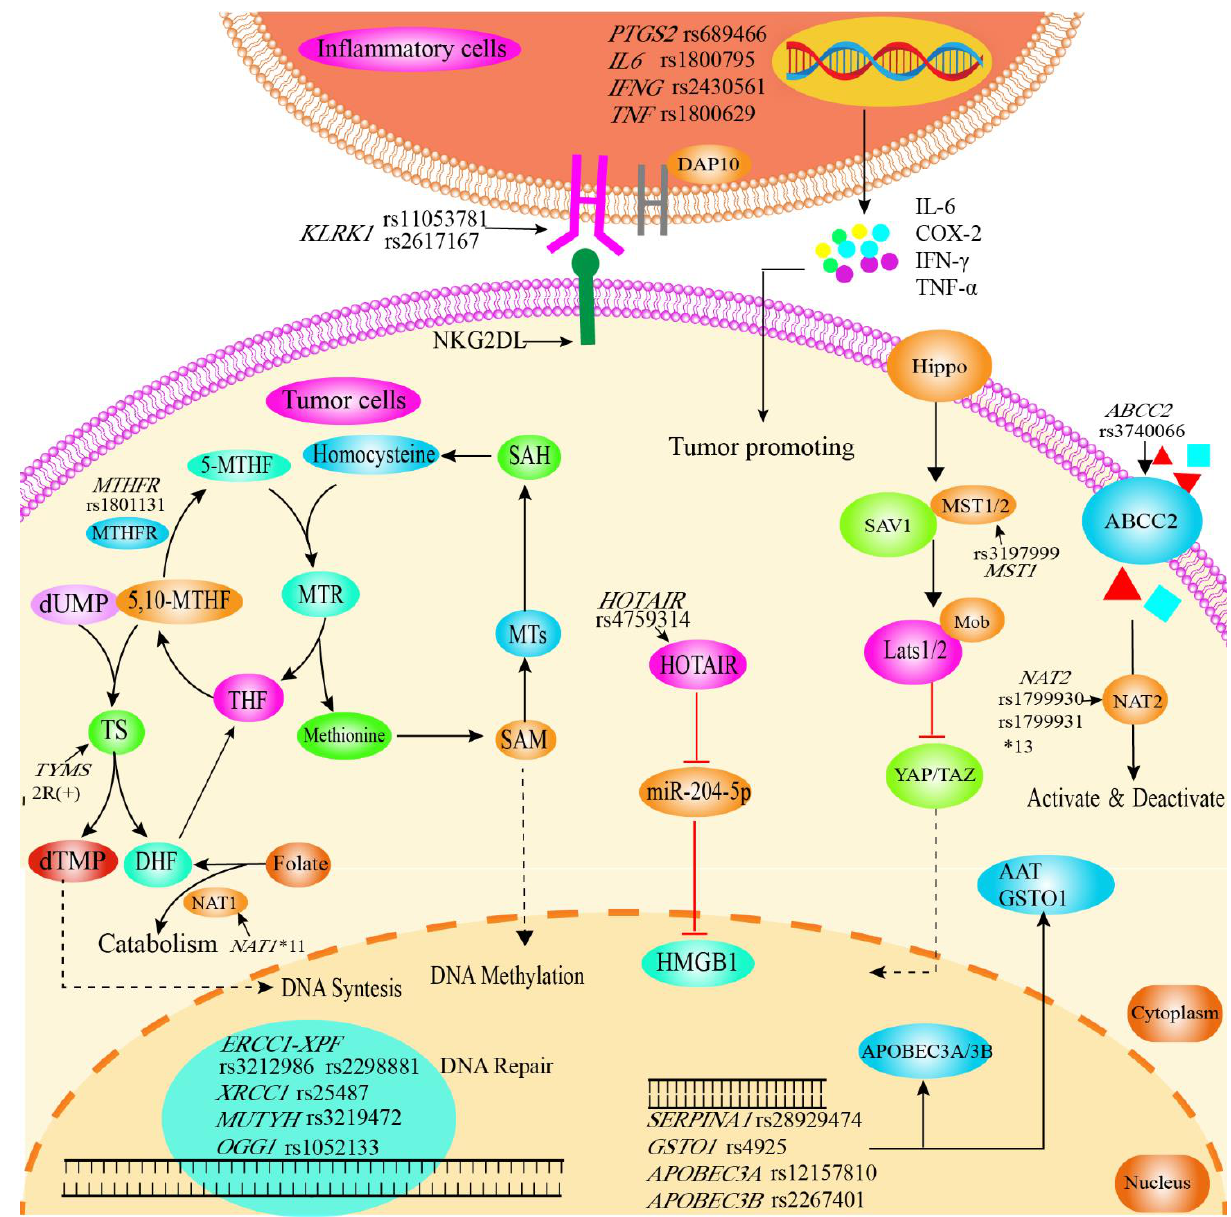
Figure 4. Graphical synopsis of the role of SNPs in susceptibility to cholangiocarcinoma. SNPs in genes related to inflammation, DNA repair, cellular protection against toxins, RNA, enzymes and membrane proteins are related to susceptibility. Polymorphisms in inflammatory genes ( IL6 rs1800795, INF-γ rs2430561, TNF-α rs1800629) affect levels of inflammatory cytokines, which play a rs1800795, INF- γ rs2430561, TNF- α rs1800629) affect levels of inflammatory cytokines, which play